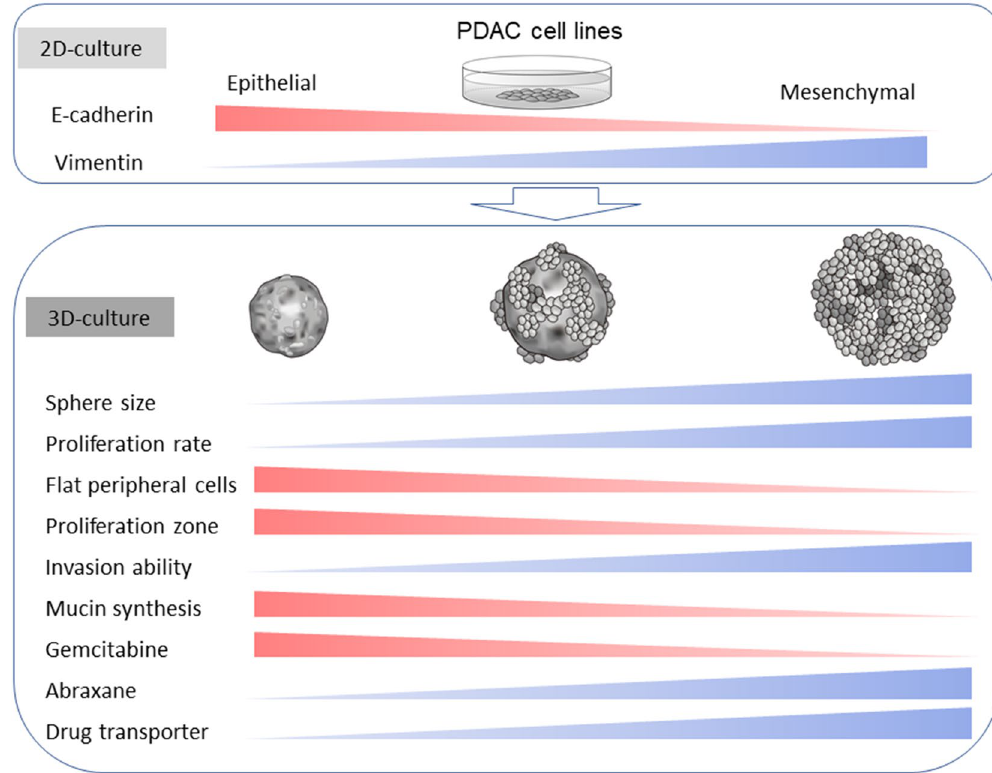
Figure 6. A hypothetical model of the characteristics of PDAC cell lines in 2D and 3D culture. Most PDAC cells show pleomorphic morphology under 2D culture and display epithelial-to-mesenchymal features. In the 3D culture, the PDAC cells form spheres of different shapes with various cellular